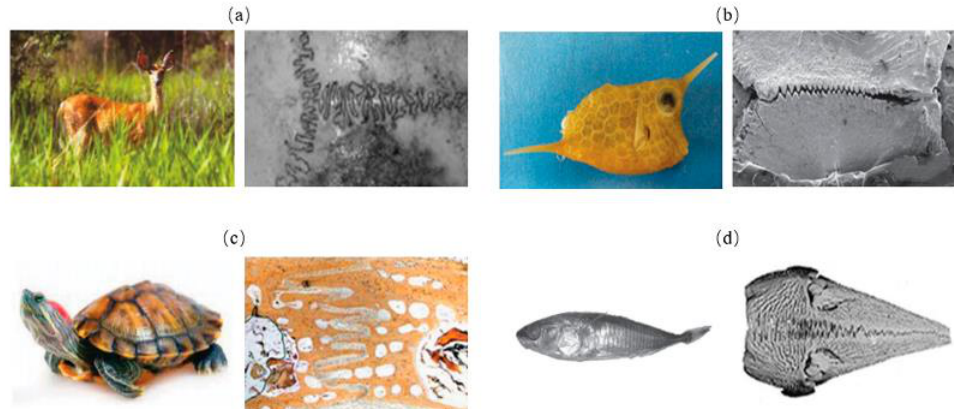
Figure 10. Biological tissue sutured structures. ( a ) deer skull [54] Copyright© 2009, Journal of Morphology ( b ) boxfish scales [55] Copyright©2015, Acta Biomaterialia ( c ) turtle shell [56] Copyright©2009, Advanced Materials ( d ) spiny fish pelvic bone [57]. Copyright©2019, Journal of the Mechanical Behavior of Biomedical Materials.